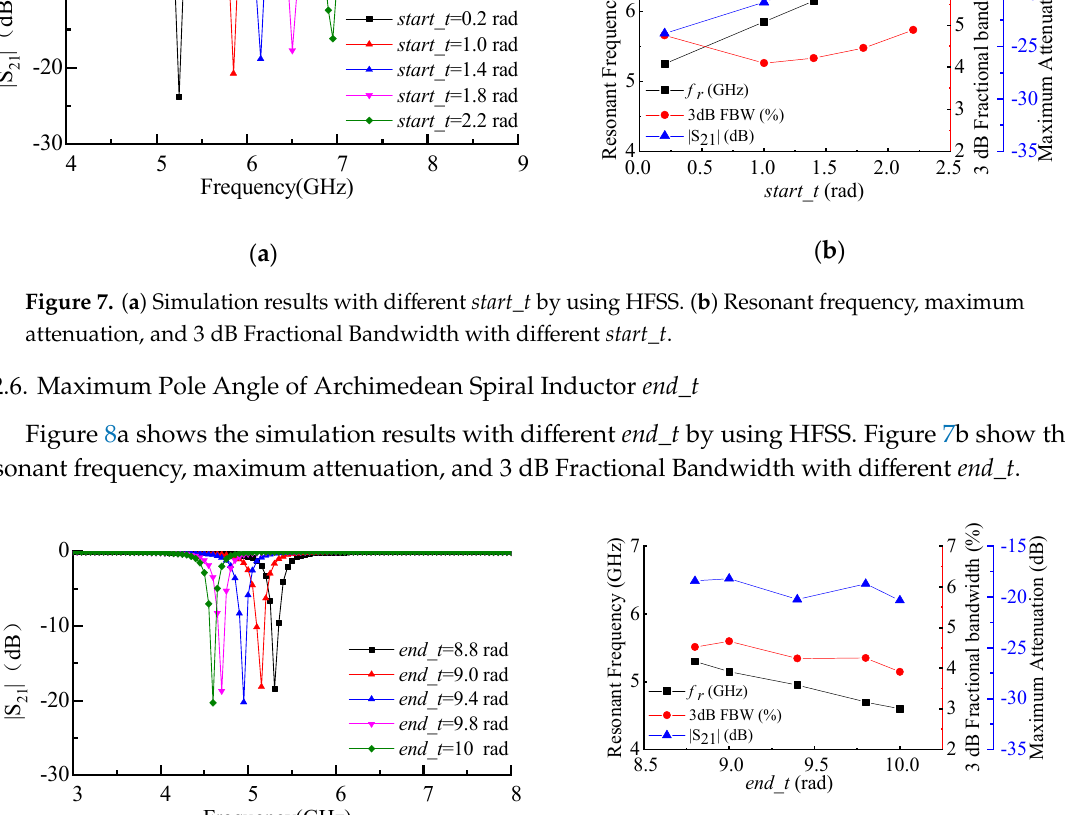
Figure 7. ( a ) Simulation results with different start_t by using HFSS. ( b ) Resonant frequency, maximum attenuation, and 3 dB Fractional Bandwidth with different start_t.